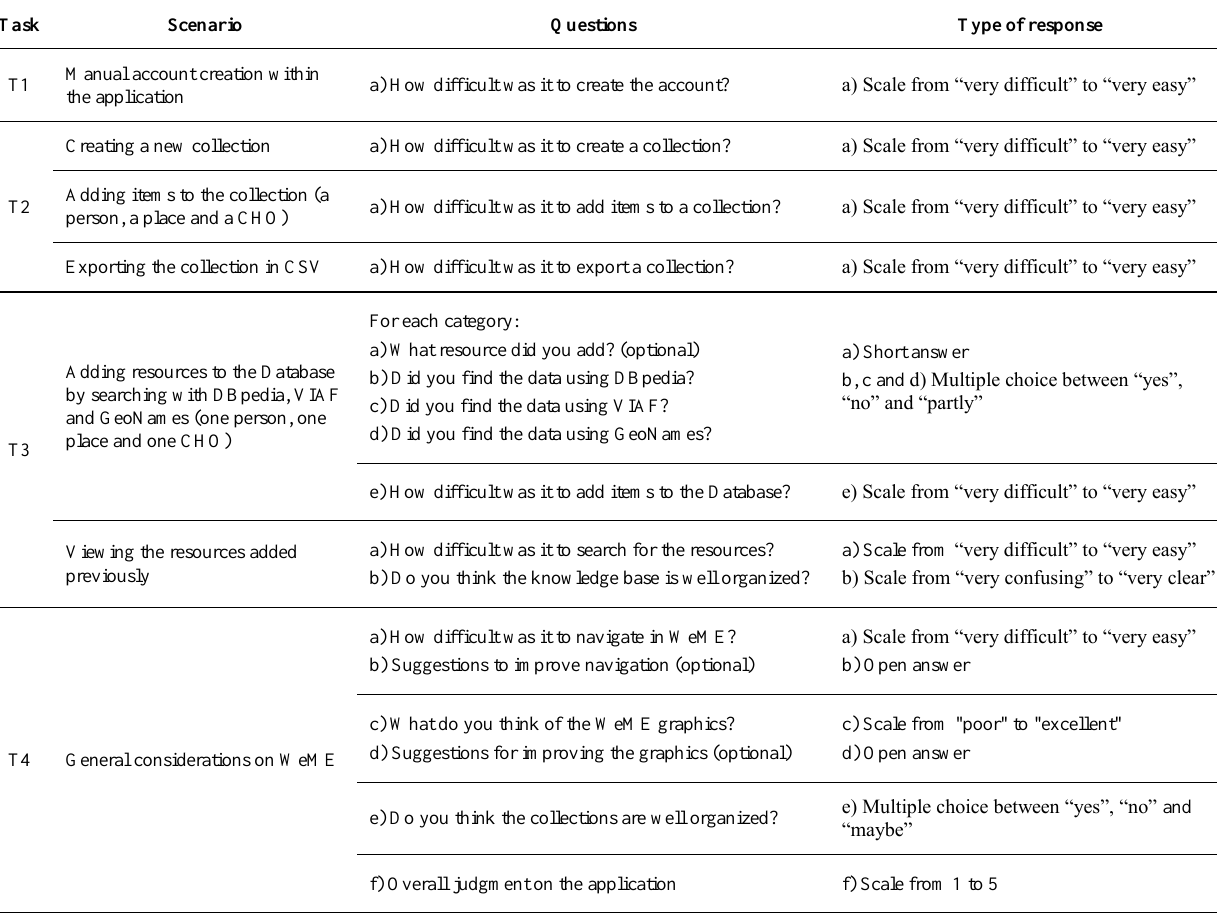
Table 2. Usage scenarios and respective questions